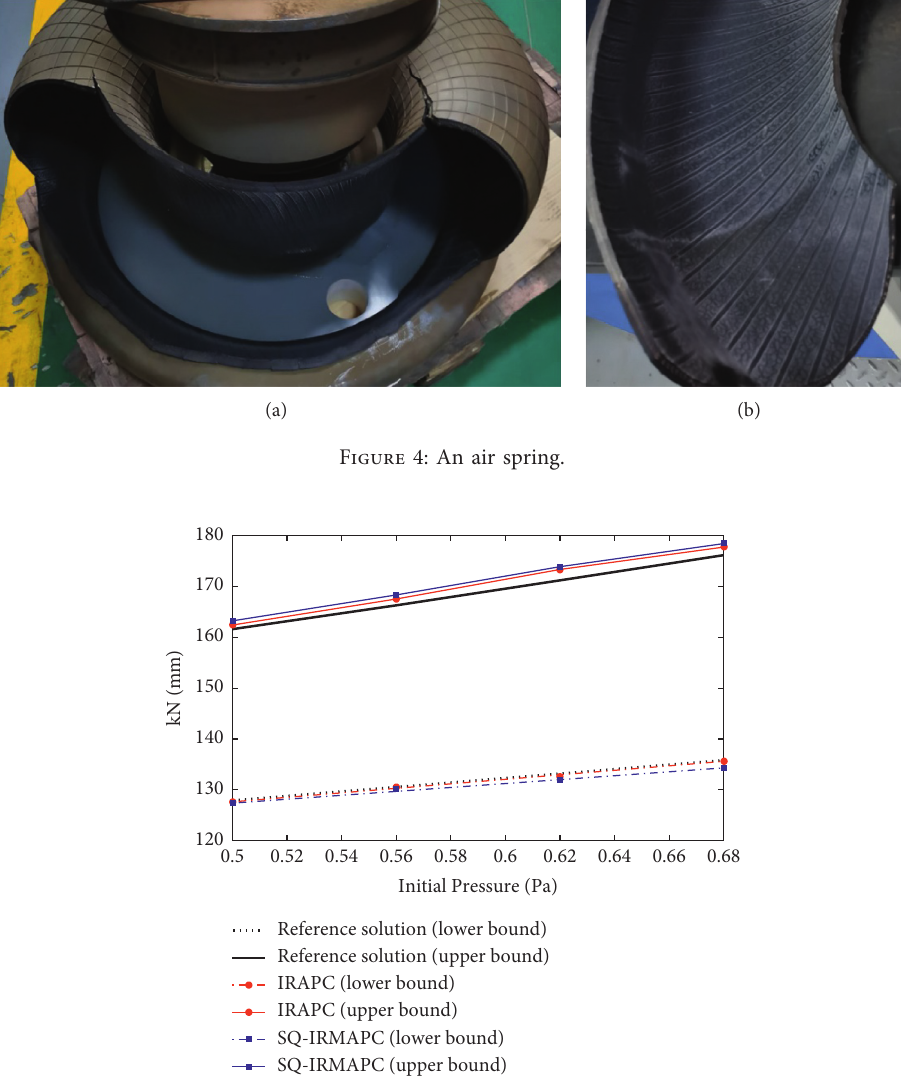
Figure 5: Stiffness of the air spring with different initial